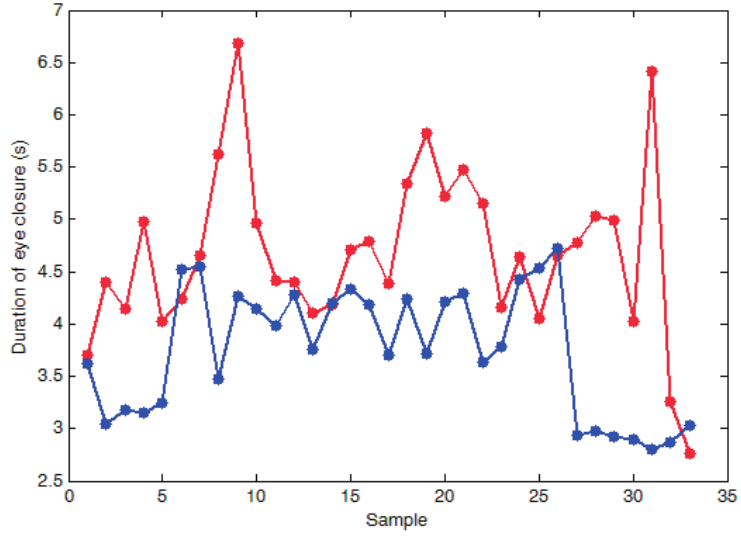
Figure 7. Duration of eye closure for 33 different time series.